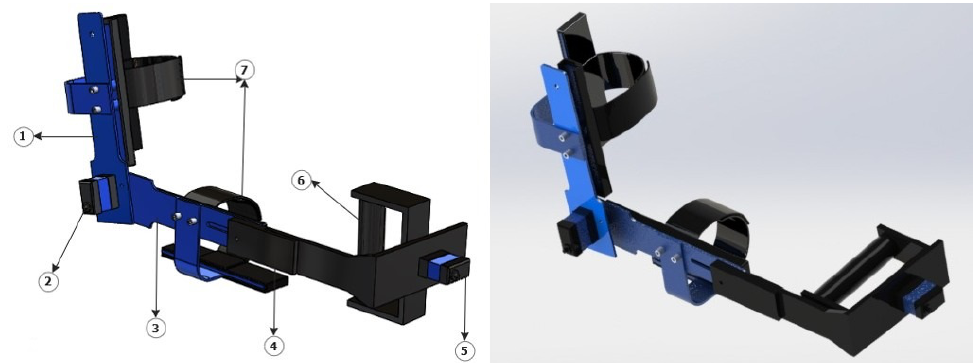
Figure 5. CAD design of an upper torso rehabilitative orthosis prototype.